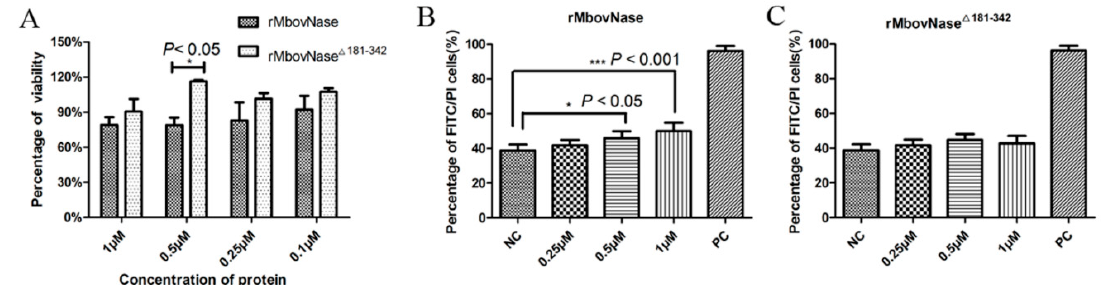
Figure 7. Cytotoxic effect of rMbovNase on BoMac cells. ( A ) BoMac cells treated with rMbovNase or rMbovNase Δ 181–342 proteins for 24 h at 37 °C, and cell viability was determined by MTT assay. Flow cytometry assay on BoMac cells treated with rMbovNase ( B ) and rMbovNase Δ 181–342 ( C ) protein for 24 h and stained with Annexin V and propidium iodide (PI). PBS treatment was taken as a negative control (NC); apoptosis inducer from the commercial kit was a positive control (PC). * and *** represent p < 0.05 and 0.001